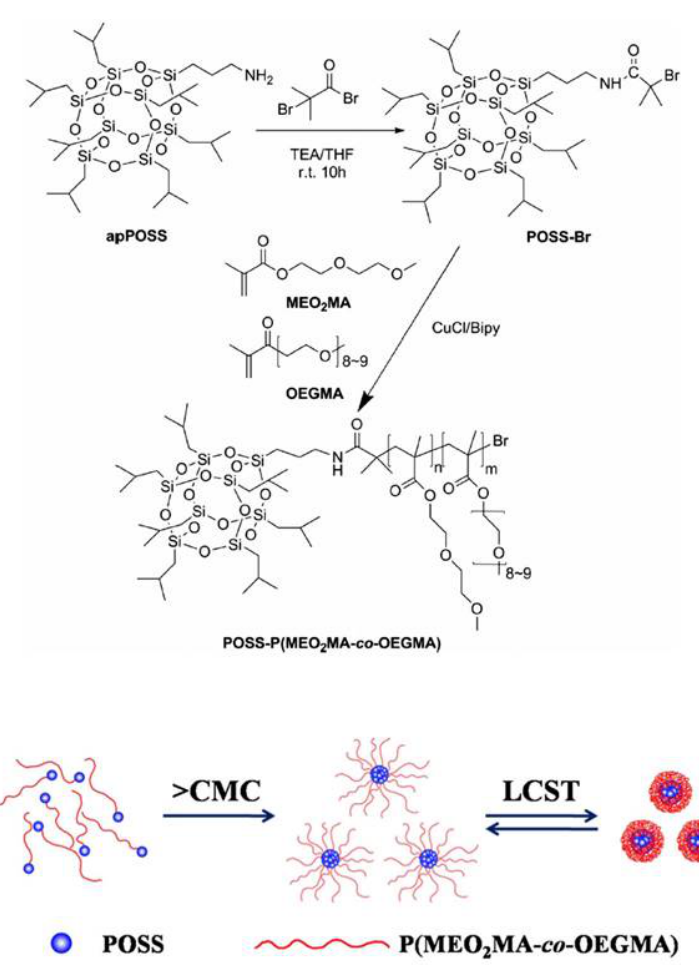
Figure 5. Synthesis of thermoresponsive POSS–P(MEO 2 MA- co -OEGMA) and schematic self-assembly process of the POSS–P(MEO 2 MA- co -OEGMA) in water in response to temperature. Reprinted with permission from [105]. Copyright (2014) Springer Nature.